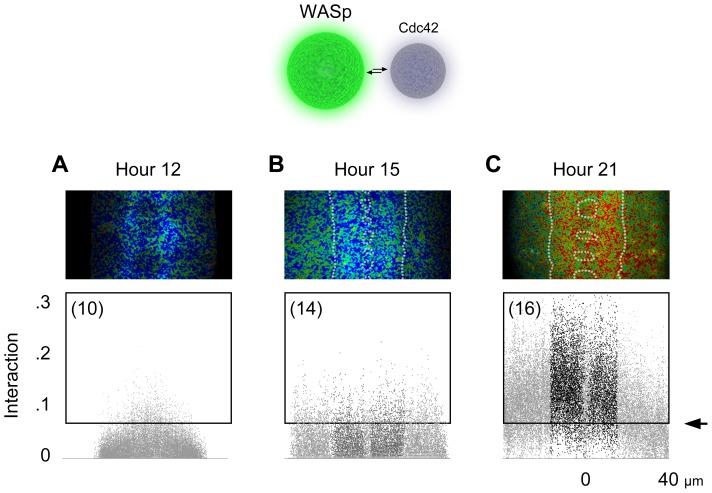
WASp-to-Cdc42 interaction.A–C. Interaction between Cdc42 and WASp before (A), at the onset of (B), and after the formation of neuropil (C).